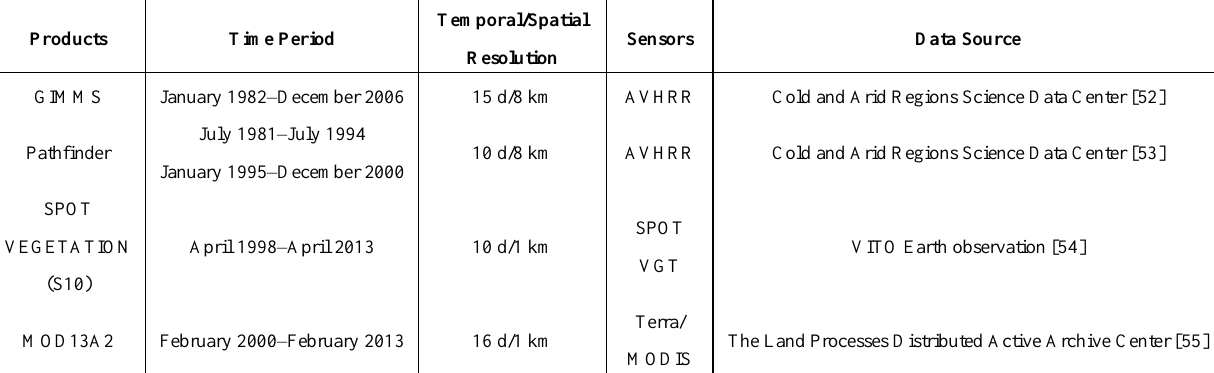
Table 1. Long time-series Normalized Difference Vegetation Index (NDVI) data sets used in the